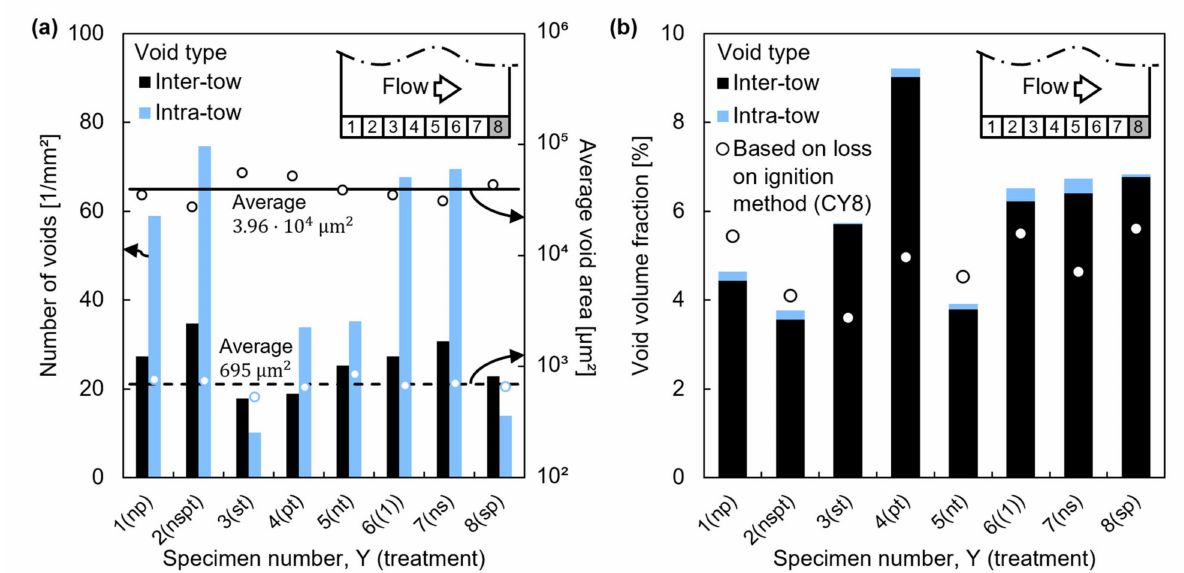
Figure 8. Size, occurrence, and total inter- and intra-tow void content: ( a ) Voids occurrence and average void area, A 0 ; ( b ) Void area fraction, a 0